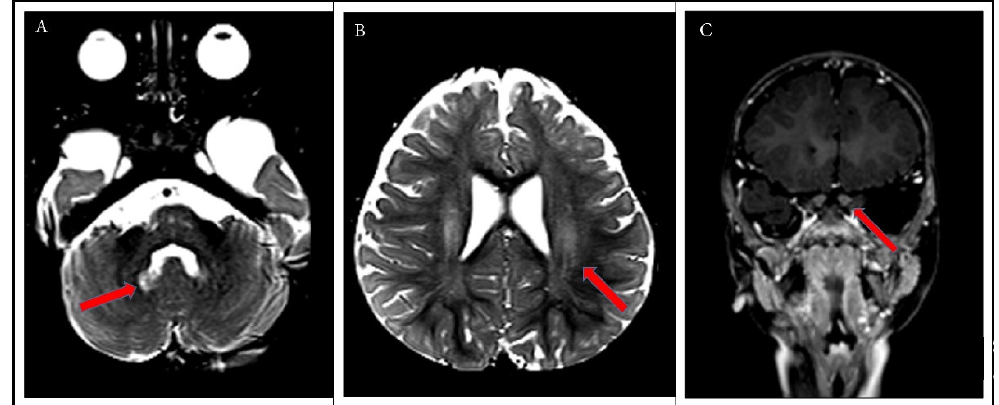
Figure 2. The brain MRI at 12 months of life, showing, as indicated by red arrows, mild symmetric non-enhancing T2 hyperintensities involving the bilateral dentate nuclei ( A ), corona radiata and centrum semiovale ( B ), as well as fusiform enlargement of the bilateral optic nerves ( C ).